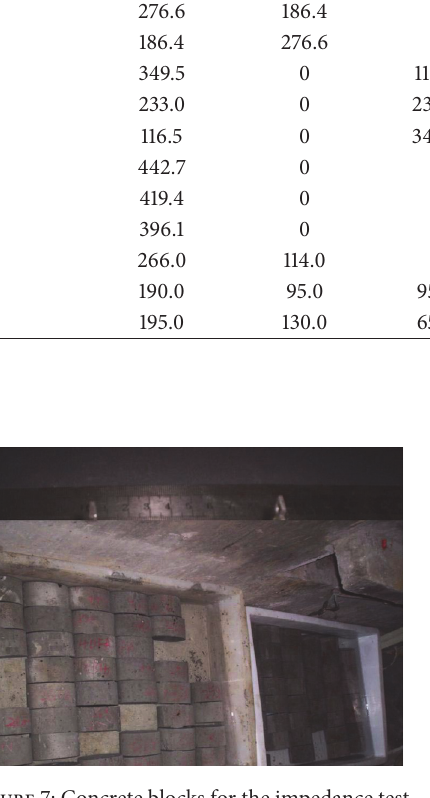
Figure 7: Concrete blocks for the impedance test.